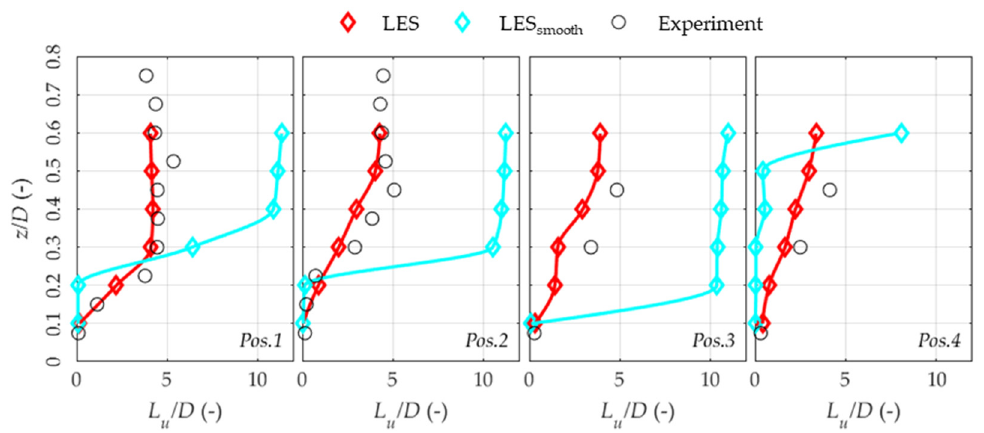
Figure 14. Integral length scale of turbulence for position 1 and position 2.